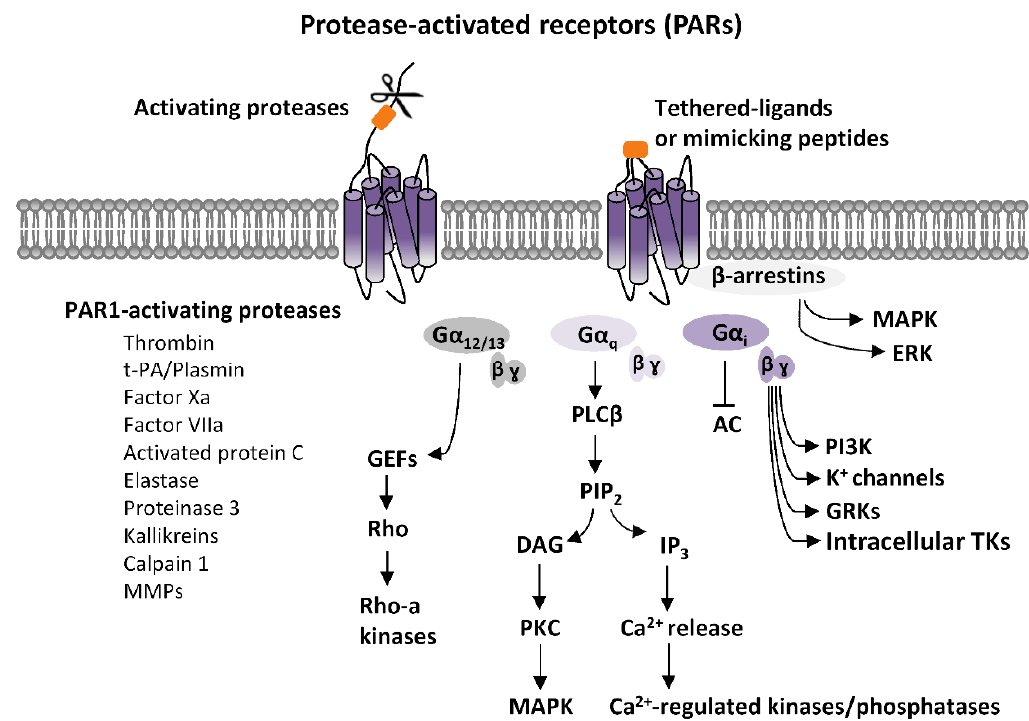
Figure 1. Protease-activated receptors (PARs) signaling. Scheme of the principal PARs-dependent signaling pathways. PARs activation, elicited by proteases-induced unmasking of tethered ligands or, alternatively, by ligand-mimicking peptides, stimulates various G proteins-dependent pathways. G α q -mediated activation of phospholipase C β (PLC β ) results in the hydrolysis of phosphatidylinositol and generation of inositol-1,4,5-trisphosphate (IP 3 ) and diacylglycerol (DAG), that fosters Ca 2+ intracellular mobilization from internal stores, and activation of Ca 2+ -regulated kinases and phosphatase. Protein kinase C (PKC), which is also activated by DAG, stimulates mitogen-activated protein kinases (MAPK). PARs coupling with G α 12/13 , that binds to guanine nucleotide exchange factors (GEFs), results in the activation of the small soluble G protein, Rho, and, consequently, of Rho-activated kinases. PARs-induced activation of Gi, inhibits, via G α i,, adenylyl cyclase (AC), and, via the βγ subunit, produces opening of G protein-activated inward rectifying K + channels (GIRK), the activation of G protein-coupled receptor kinases (GRKs), as well as the stimulation of intracellular tyrosine kinases (TKs), and the activation of phosphotydil-inositole-3-kinase (PI3K), that then activates other kinases signaling pathways, including mitogen-activated protein kinase (MAPK). Additionally, PARs stimulations can activate G protein-independent mechanisms, mediated by the recruitment of β -arrestins and activation of diverse signaling pathways, including MAPK-like extracellular signal-regulated kinases